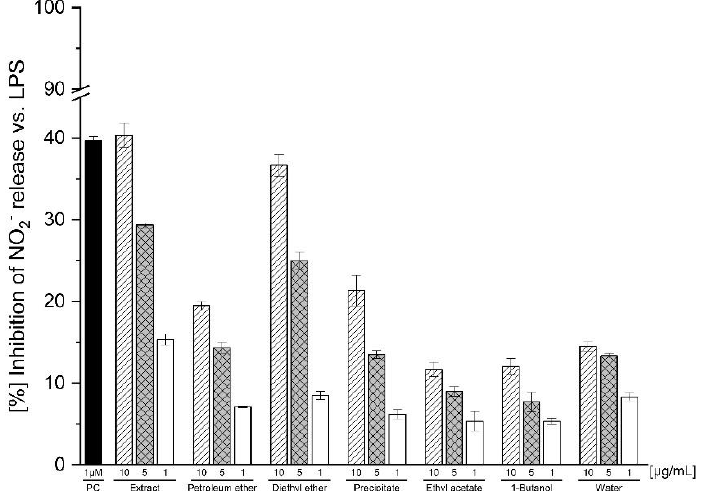
Figure 1. Inhibitory effects of the methanolic extract (Extract) and its subfractions (Petroleum ether, Diethyl ether, Precipitate, Ethyl acetate, 1-Butanol, and Water) obtained from the methanolic rhizomes and roots extract of C. articulatus on LPS-stimulated J774A.1 murine macrophages, which were incubated with subfractions at concentrations of 10, 5, and 1 µg mL −1 , followed by measurement of the NO production vs. LPS ± SEM ( n = 3). L-NAME was used as positive control (PC) at a concentration of 1 µM.